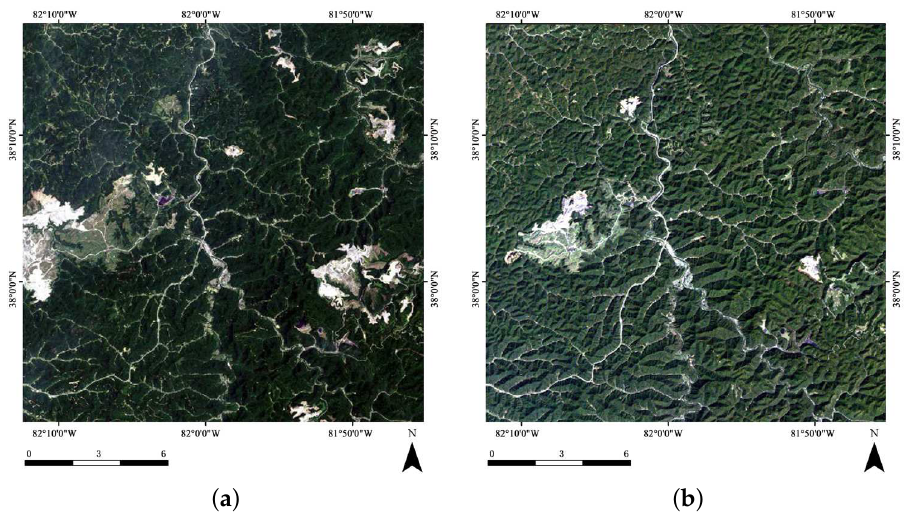
Figure 5. TM data set. The size of TM images is 950 × 950 pixels with 30 m spatial resolution. ( a ) Hobet mine, TM, 4 October 1996; ( b ) Hobet mine, TM, 2 June